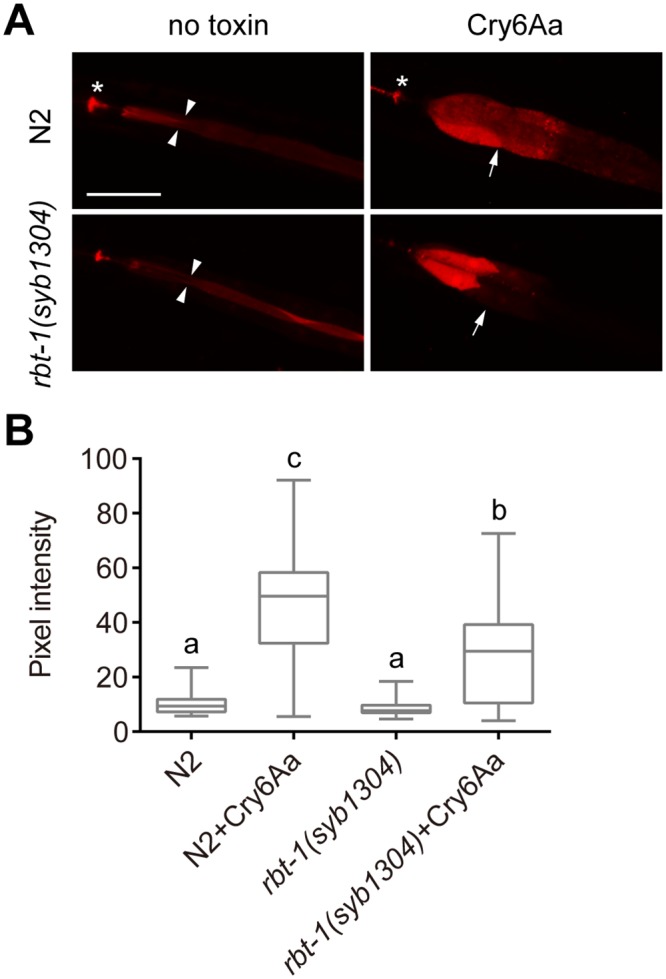
RBT-1 is involved in propidium iodide uptake mediated by Cry6Aa in C. elegans.(A) Wild-type N2 or mutant rbt-1(syb1304) were exposed to 50 μg/ml Cry6Aa or no toxin before propidium iodide (PI) staining, and fluorescence microscopy was used to monitor the signal of PI. Asterisks indicate pharynx; arrowheads point to intestinal lumen; arrows point to intestinal cells; scale bar, 50 μm. (B) Quantification of pixel intensity of PI in the intestinal cells, parallel to those shown in A. Different letters indicate significant differences (n = 50 animals; P < 0.0001; one-way ANOVA). Data represented three independent experiments.